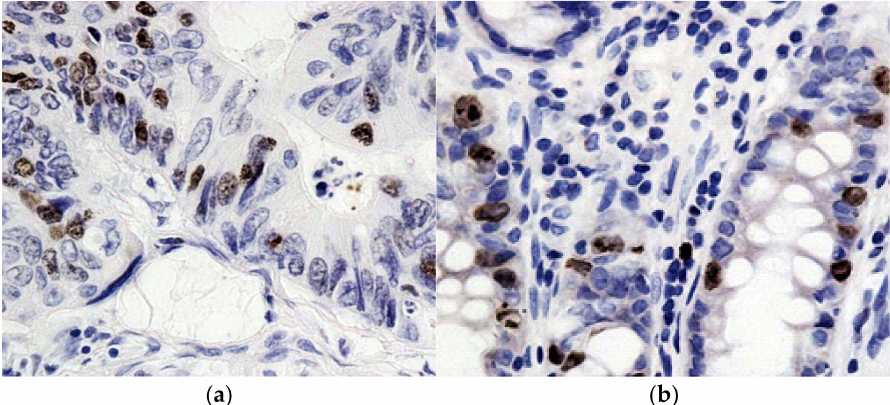
Figure 2. Immunohistochemical reaction with antibodies to Ki67 in adenocarcinoma and in the resec- tion region. ( a ): moderately expressed expression of Ki67; ( b ): expression of Ki67 in the resection edge. Chromogen–diaminobenzidine. Control staining with hematoxylin staining. Magnification: ×